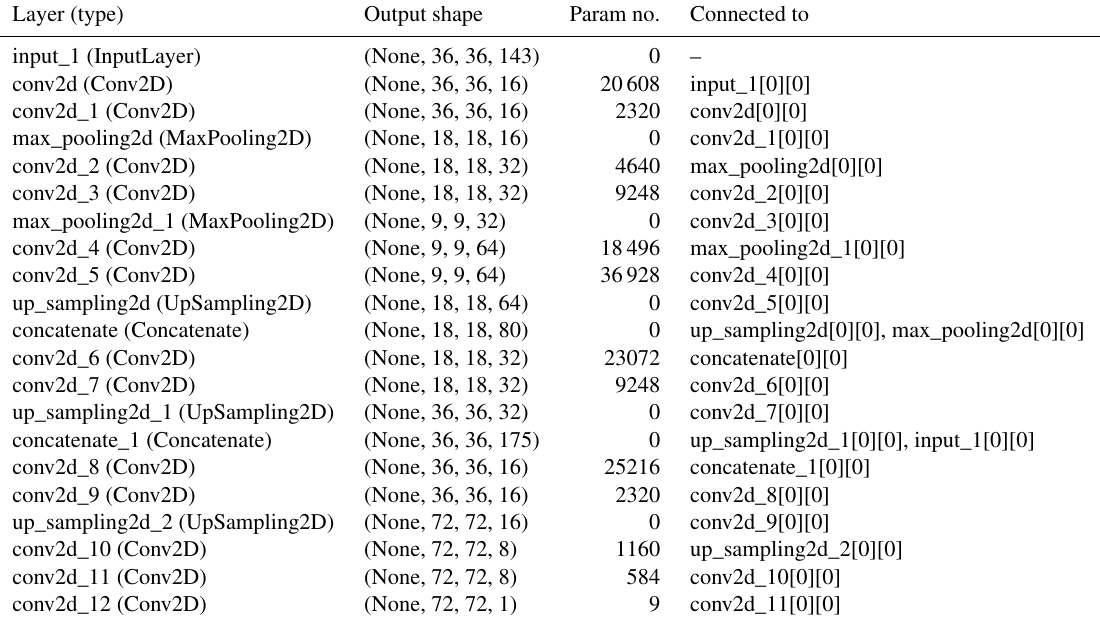
Table A1. Following the architecture proposed by Ronneberger et al. (2015) and Ayzel et al. (2020), the U-Net architecture was adapted to the input and output size of the current task using the following